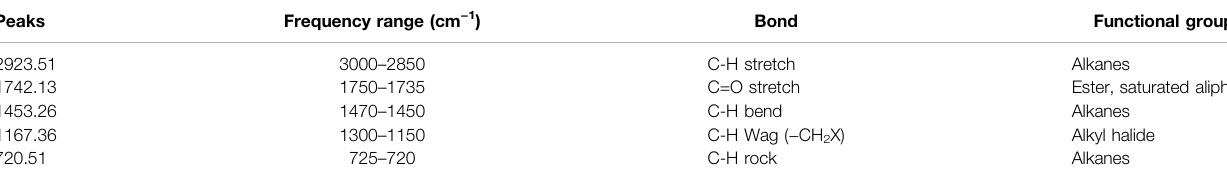
TABLE 2 | FT-IR spectroscopy showing various peaks in the Dodonaea biodiesel. Peaks